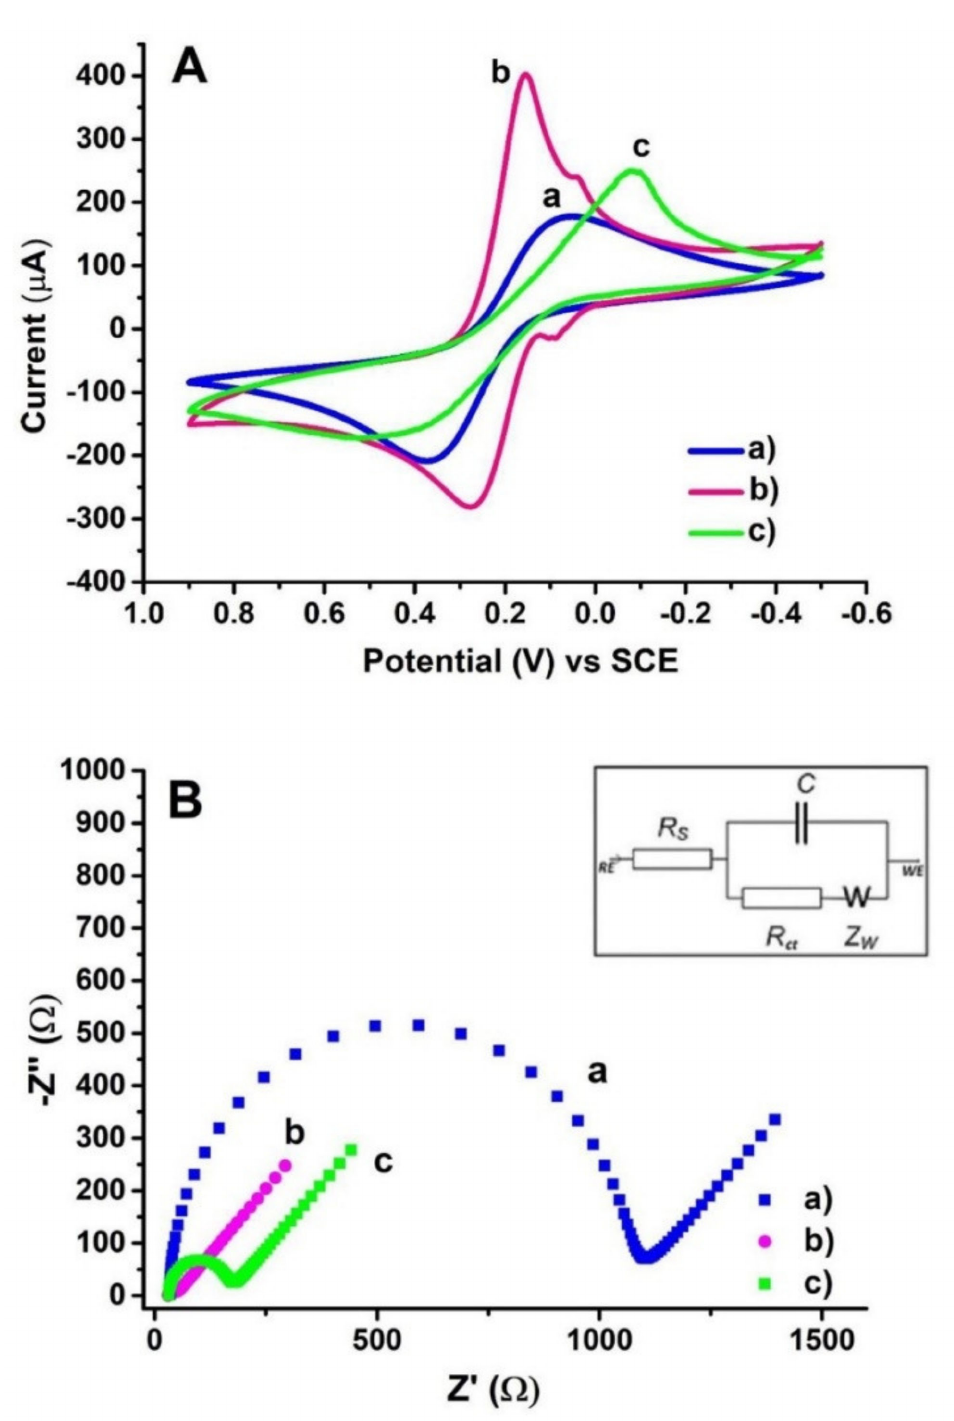
Figure 9. Electrochemical characterization of the surface layer assembly. ( A ) CVs at a scan rate of 100 mVs − 1 and ( B ) The Nyquist diagrams of impedance recorded on (a) bare PGE, (b) PGE coated with poly(CTAB-MWCNTs), (c) 150 µ g/mL dsDNA immobilized poly(CTAB-MWCNTs)/PGE in 0.1 M KCl solution containing 5.0 mM Fe(CN) 6 3 − / 4 − (Inset represents the equivalent circuit model for fitted impedance data. R s is the solution resistance; R ct is the charge transfer resistance at the electrode/electrolyte interface; C is the constant phase element related to the space charge capacitance at the electrode/electrolyte interface; W is the Warburg element). Figure adapted from the reference [55] with permission from